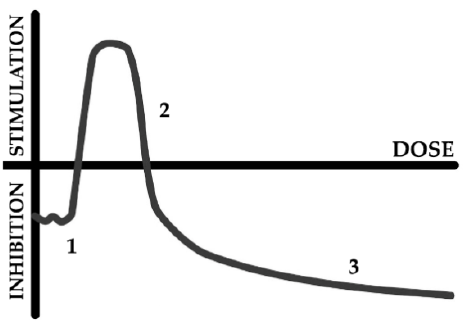
Figure 1. Scheme of hormesis dose–response model. The response includes stages of stress recognition (1), stimulation (activation) (2), and inhibition (3).